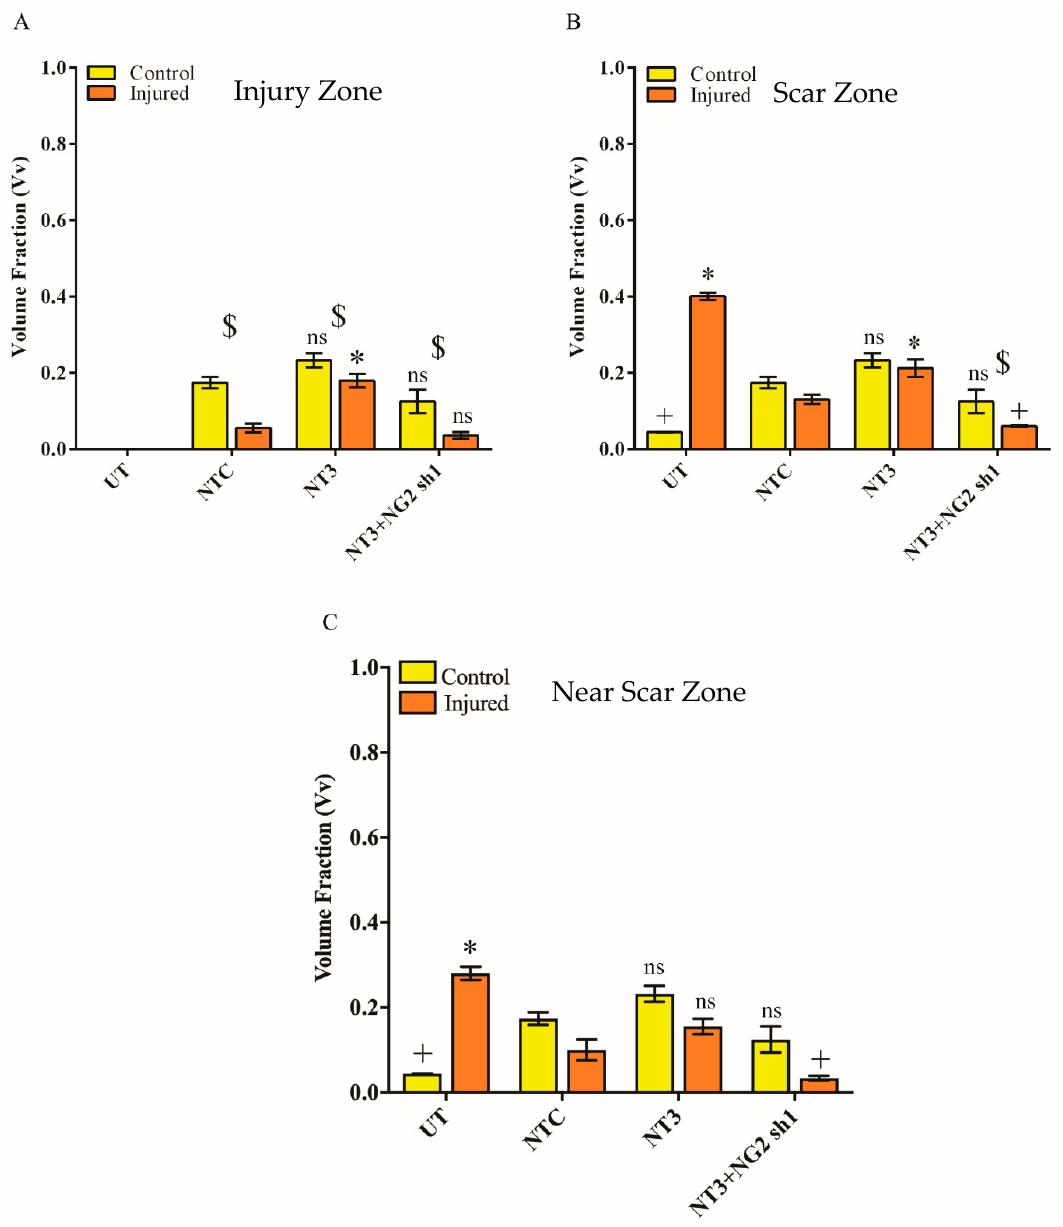
Figure 8. Vv of NG2 in untransduced and lentiviral vector transduced control and transection injured ex vivo spinal cord slices. Graphs show Vv NG2 immunohistochemical staining at the IZ ( A ), SZ ( B ) and NSZ ( C ). UT = untransduced, NTC = non-targeting control. Mean ± SEM. * p ≤ 0.001 significant increase from NTC, + p ≤ 0.001 significant decrease from NTC, $ p ≤ 0.001 significant di ff erence between control and injured groups, ns indicates no significant di ff erence compared to the NTC or between control and injured groups. The mean di ff erences were analysed using two-way ANOVA. n = 3 litters (12 pups per litter) which relates to six slices per control group per time-point and nine slices per injured.